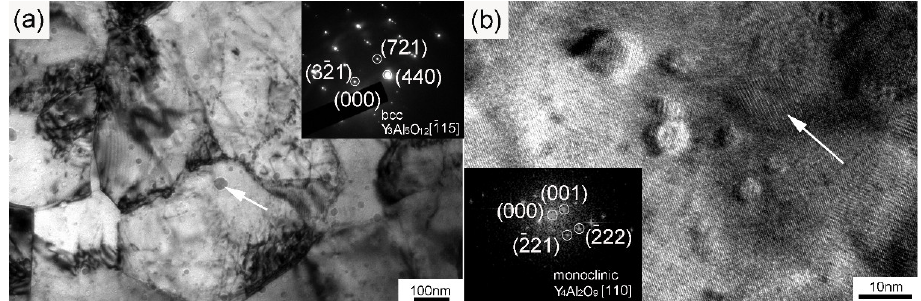
Figure 4. ( a ) TEM image of dispersed nanoparticles in the sample with a selected area diffraction (SAD) pattern of a Y 3 Al 5 O 12 nanoparticle (marked by the arrow); ( b ) HRTEM image of dispersed nanoparticles in the sample with a fast Fourier transformation (FFT) pattern of a Y 4 Al 2 O 9 nanoparticle (marked by the arrow).